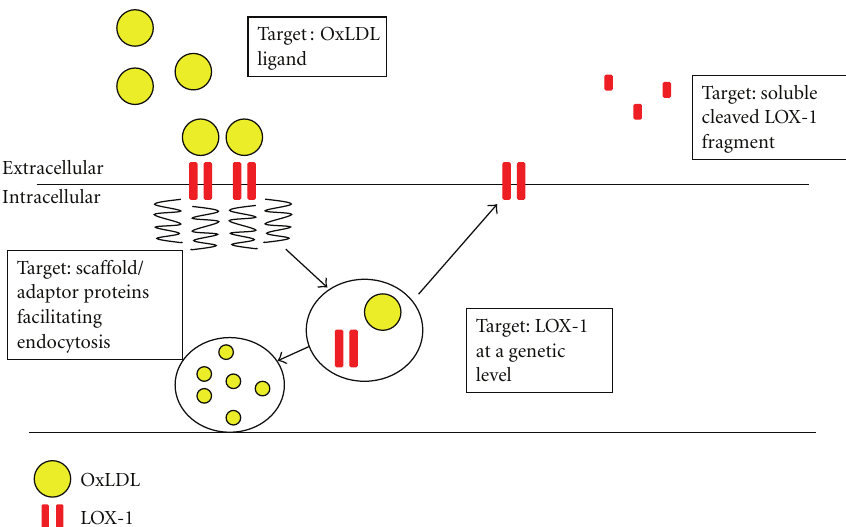
Figure 3: Schematic diagram showing potential routes towards blocking OxLDL and/or LOX-1 function and tra ffi cking to attenuate the pathological process of